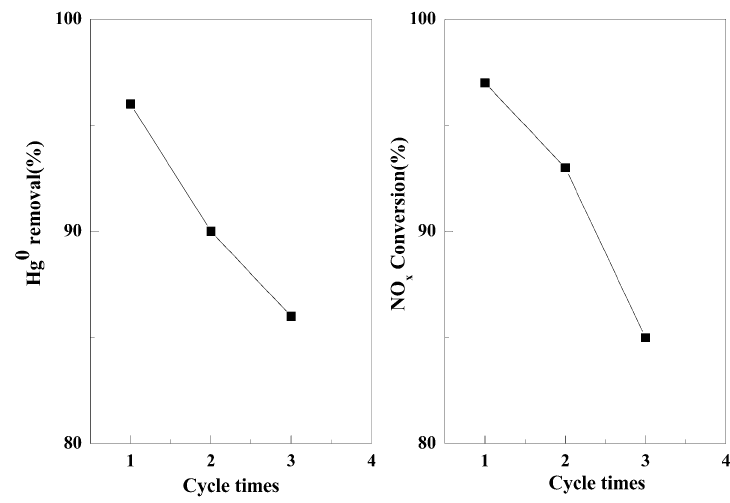
Figure 10. Regeneration performance of the sorbent for Hg 0 and NO x removal efficiency.